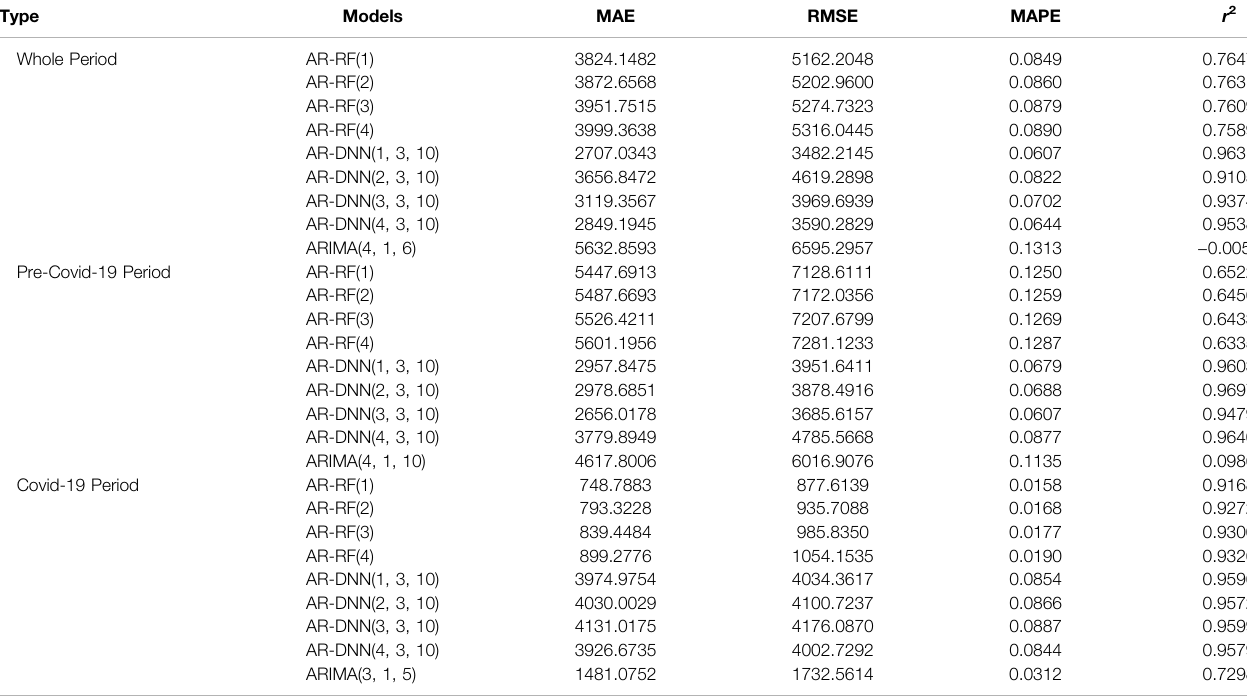
TABLE 3 | Forecasting performance Comparison of different models for stock index using test data. Type